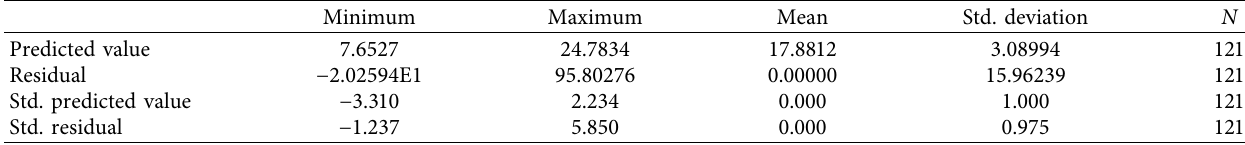
Table 8: Residuals